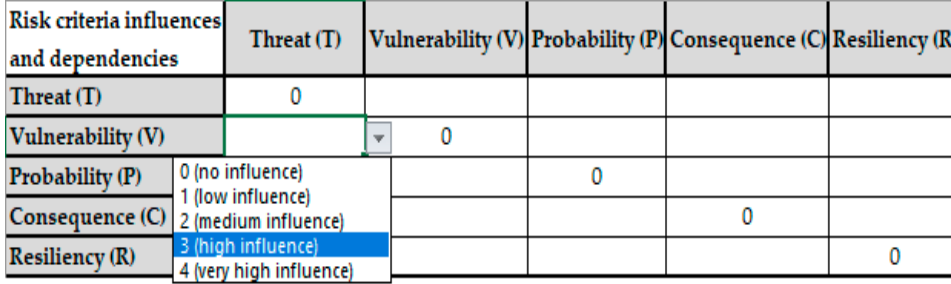
Figure 3. Matrix for estimating influences and dependencies between ISRA criteria.